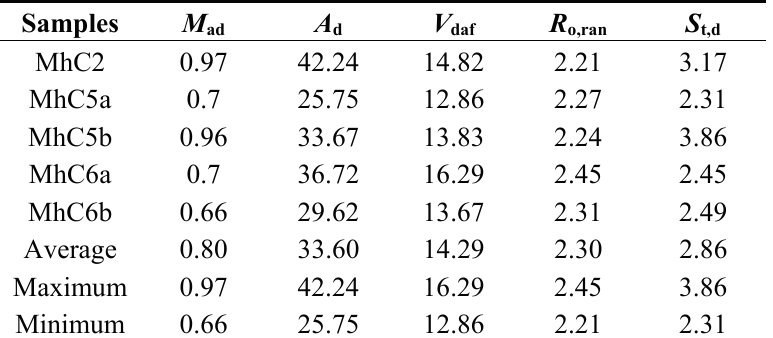
Table 1. Random vitrinite reflectance, proximate analyses, and total sulfur in coals from the Mahe mine